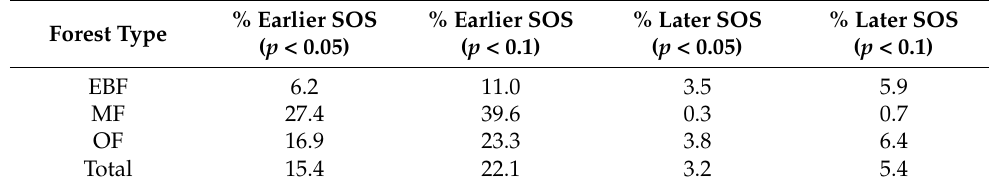
Table 1. Proportions of SOS trends for different forest types. EBF, evergreen broadleaf forests; MF, mixed forests; OF, open forests.